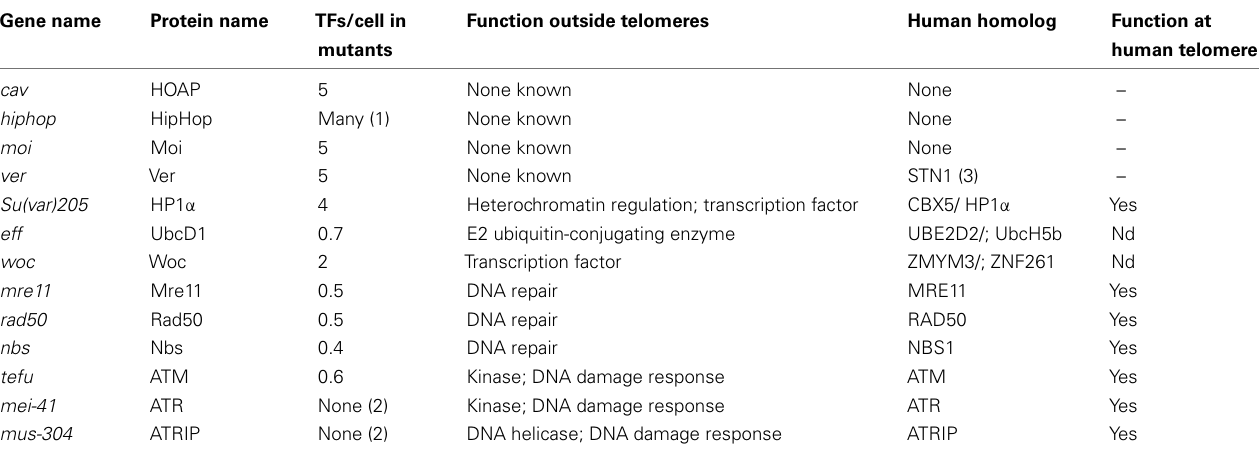
Table 1 | Drosophila genes required to prevent telomere fusion in mitotic